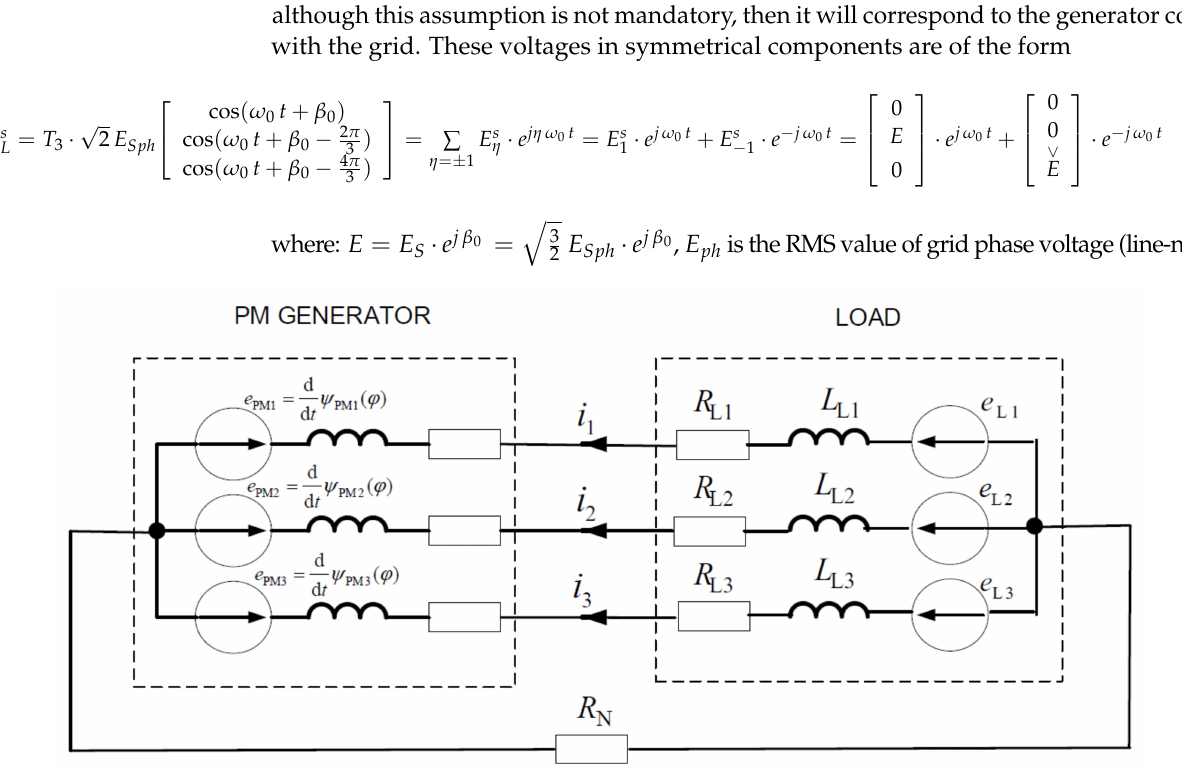
Figure 1. The PM generator under example